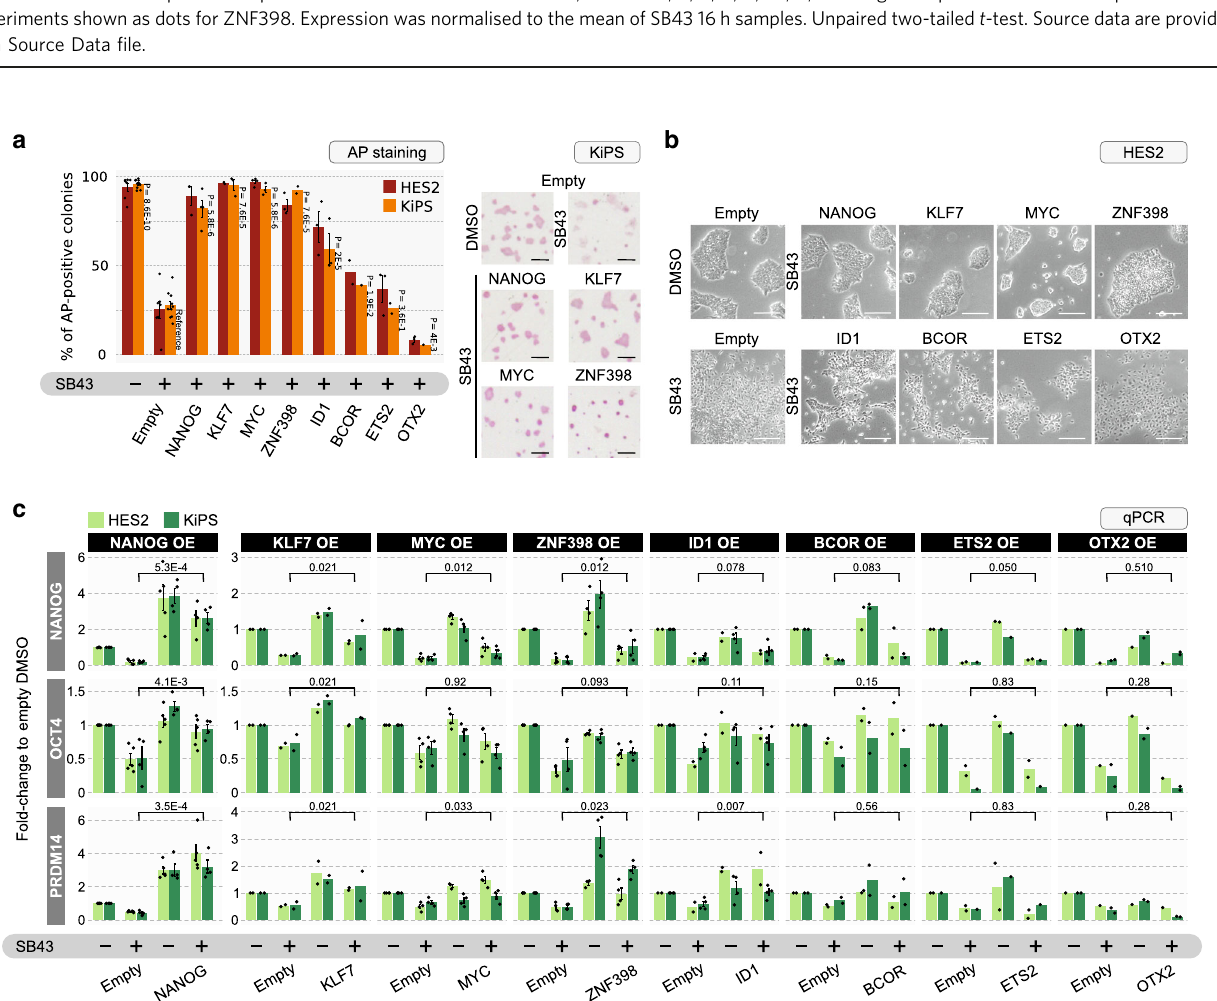
Fig. 3 Functional identi fi cation of pluripotency regulators in hPSCs. a Left: Clonal assay quanti fi cation of hESCs (HES2, red bars) and hiPSCs (KiPS, orange bars) stably expressing an empty vector control (Empty) or eight different SMAD3 targets identi fi ed in Fig. 2a. Two thousand cells were seeded at clonal density in the presence of DMSO or SB43 and stained for alkaline phosphatase (AP) after 5 days. Bars show the mean ± SEM percentage of AP- positive colonies. Dots represent independent experiments ( n = 7, 10 for Empty DMSO; n = 7, 10 for Empty SB43; n = 3, 4 for NANOG SB43; n = 2, 2 for KLF7 SB43; n = 4, 3 for MYC SB43; n = 3, 2 for ZNF398 SB43; n = 3, 3 for ID1 SB43; n = 2, 1 for BCOR SB43; n = 3, 2 for ETS2 SB43; n = 3, 1 for OTX2 SB43 in HES2 and KiPS, respectively). Unpaired two-tailed Mann – Whitney U test relative to Empty SB43 samples. Right: Representative images of clonal assay performed in KiPS. See also Supplementary Fig. 3a for results obtained in H9 hESCs. Scale bars 500 µ m. Source data are provided as a Source Data fi le. b Morphology of HES2 colonies stably expressing an empty vector (Empty) in presence of DMSO or SB43 and HES2 stably expressing the eight SMAD3 targets in presence of SB43. Representative images of three independent experiments are shown. See also Supplementary Fig. 3b for results obtained in H9. Scale bars 200 µ m. c Gene expression analysis by qPCR of HES2 (light green bars) and KiPS (dark green bars) stably expressing an Empty vector or the eight SMAD3 targets and treated with or without SB43 for 5 days. Bars indicate mean ± SEM of independent experiments, shown as dots ( n = 5, 5 for NANOG overexpression; n = 2, 2 for KLF7 overexpression; n = 4, 4 for MYC overexpression; n = 4, 4 for ZNF398 overexpression, n = 2, 4 for ID1 overexpression; n = 2, 2 for BCOR overexpression; n = 2, 1 for ETS2 overexpression; n = 1, 2 for OTX2 overexpression in HES2 and KiPS, respectively). Expression was normalised to the Empty DMSO samples. Unpaired two-tailed Mann – Whitney U test. Source data are provided as a Source Data fi le. NATURE COMMUNICATIONS| (2020) 11:2364